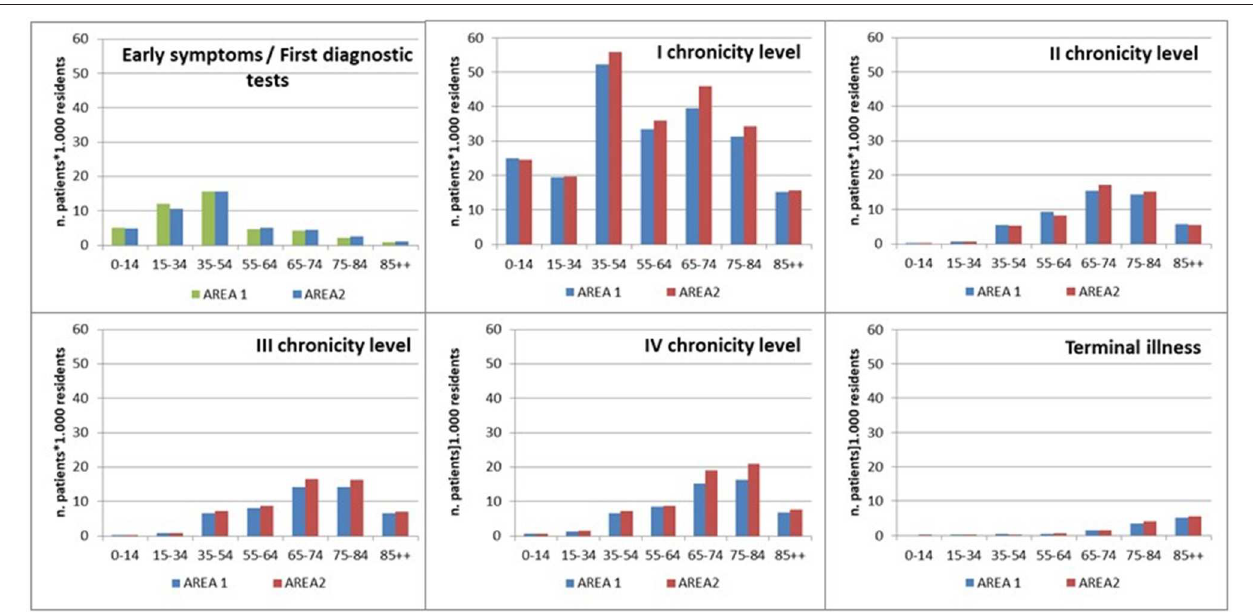
FIGURE 4 | Distribution by levels of complexity and age class.